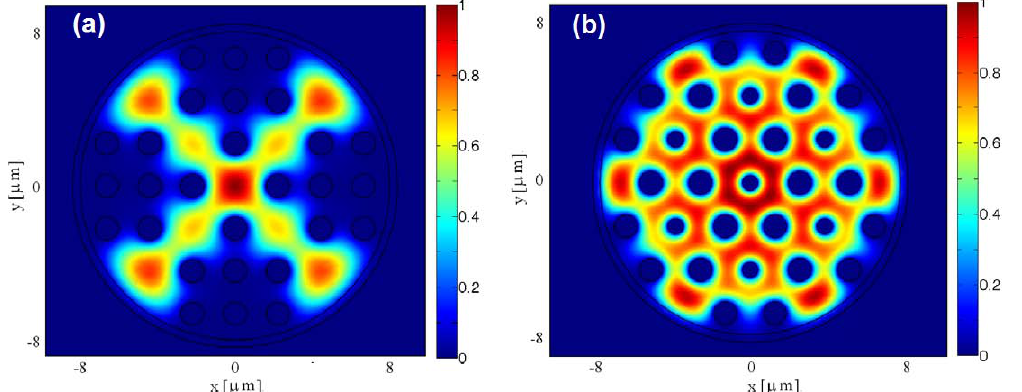
Figure 16. Simulated transverse profile of the electric field of the HE mode ( a ) for square-lattice; and ( b ) for the hexagonal-lattice photonic crystal fibers